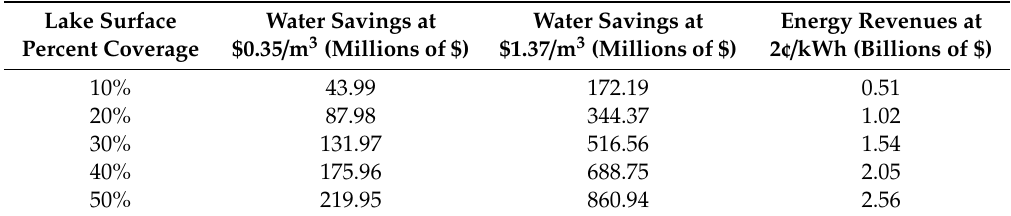
Table 2. Estimation of the yearly cost of water saved and energy produced using water and energy cost range from Nevada for an FPV system covering 10–50% of Lake Mead’s surface.